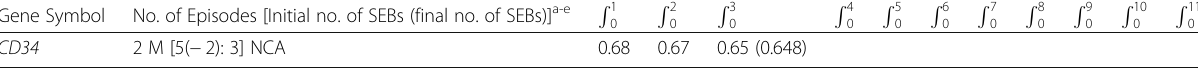
Table 2 Chromosome 1 ( − ) strand chromatin stem cell cluster of differentiation gene, CD34 , sequential esebssiwaagoT Q s to final 2- digit (and 3-digit) esebssiwaagoT Q Gene Symbol No. of Episodes [Initial no. of SEBs (final no. of SEBs)] a-e